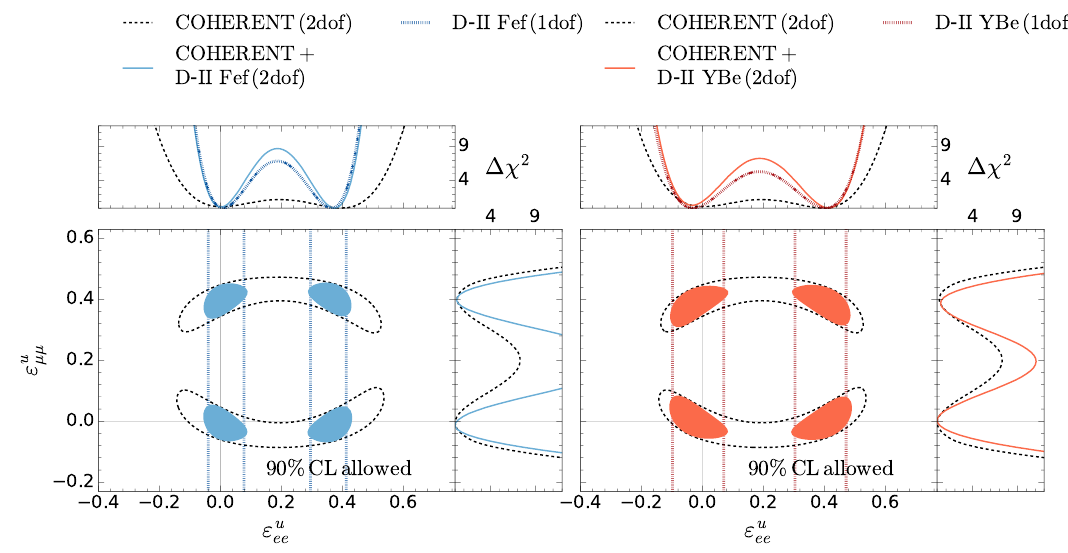
Figure 3 . 90% CL allowed regions on flavor diagonal NSI with up-quarks (for zero values of all other NSI coefficients) from the analysis of COHERENT CsI and Ar data, the Dresden-II reactor data — with Fef (YBe) quenching factor in left (right) panel –, and their combination. Note that, in the two-dimensional panels, the results for the Dresden-II reactor experiment are obtained for 1 dof ( ∆ χ 2 = 2 . 71 ), while the rest of the regions are obtained for 2 dof ( ∆ χ 2 = 4 . 61 ). NSIs with up-quarks only (the results for NSI with only down-quarks are similar). The shape of these regions for a given nucleus leads to allowed regions defined by a band around the points that approximately obey the equation of an ellipse in the ( ε u